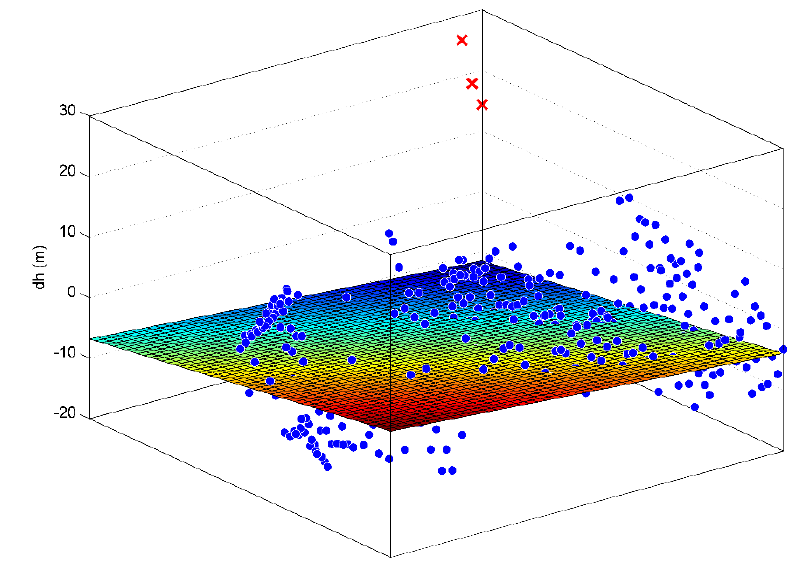
Figure 6. Example of fitted plane through elevation changes over a region. Red crosses stand for the points that had been identified as blunders by previous iterations, and thus excluded from current